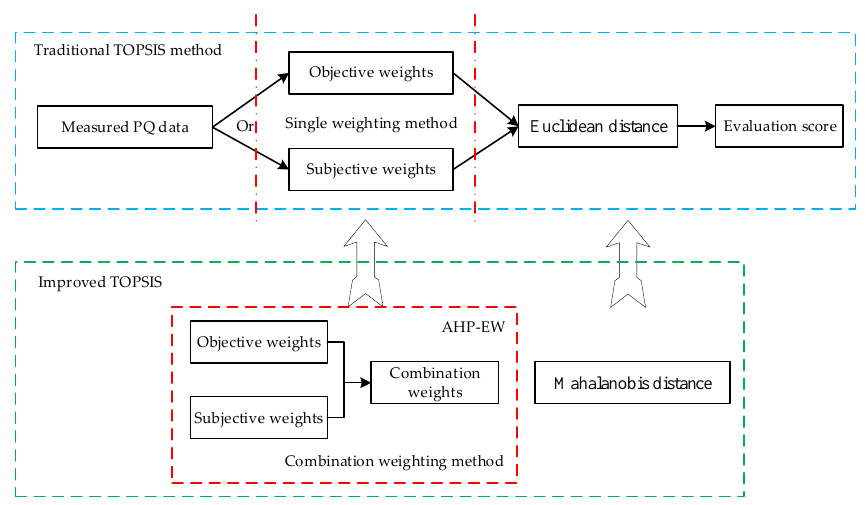
Figure 1. Improved process of the Technique for Order Preference by Similarity to an Ideal Solution (TOPSIS) method.